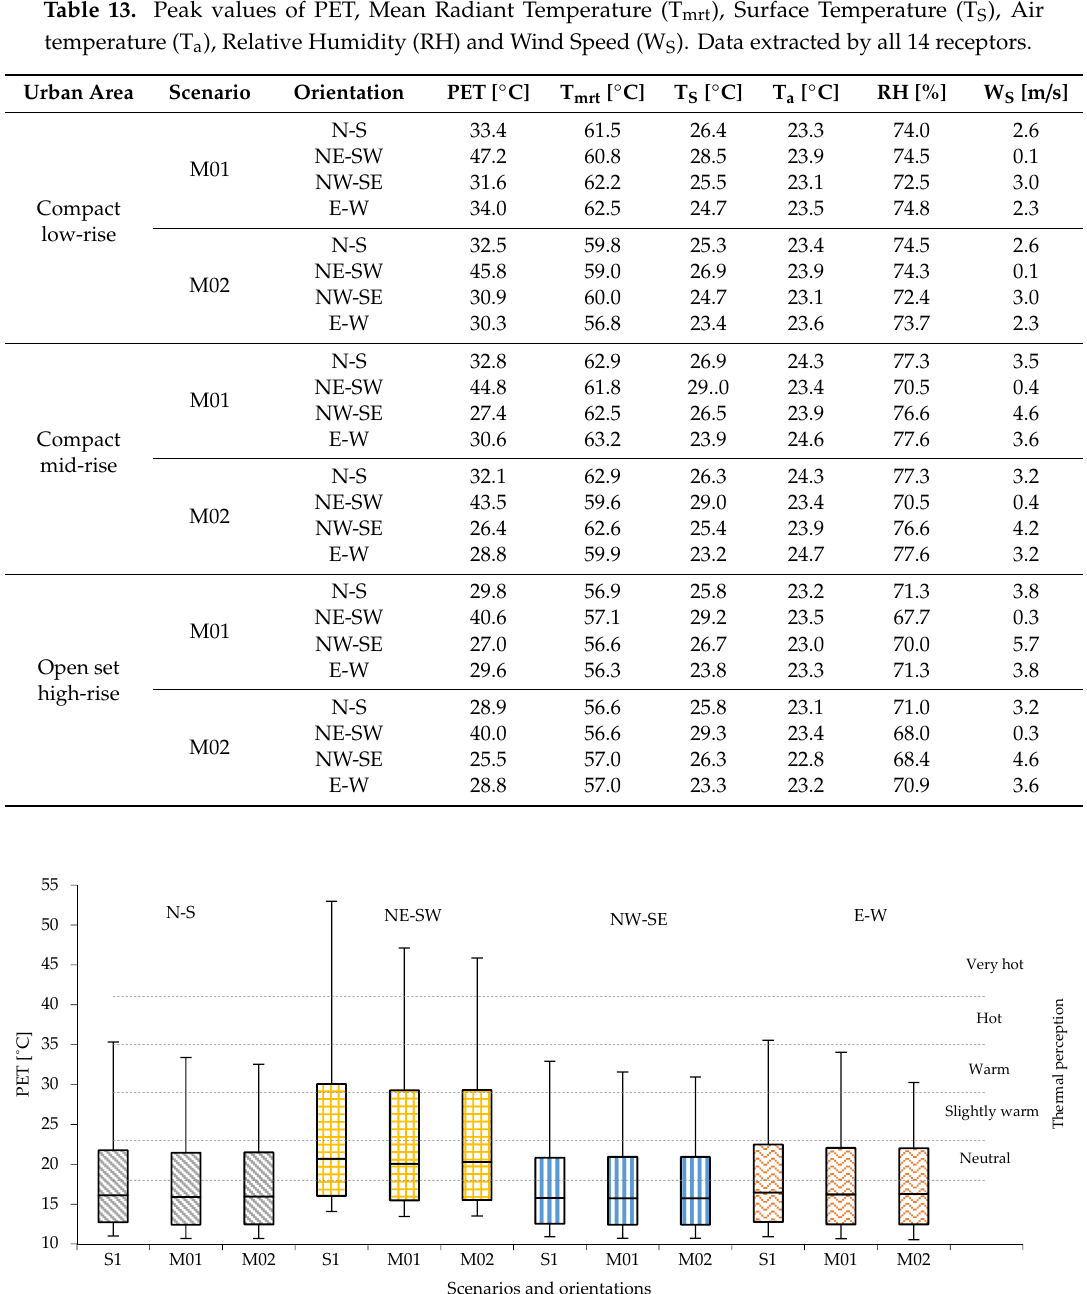
Table 14. PET peak values, for R01, R04 and R07 in compact lo-rise urban areas for the scenario with red brick stones, M01 (pavement in red brick stone and constant ratio Ht/H = 0.25) and M02 (pavement in brick red stone and constant ratio Ht/H = 0.25 and Wt/W = 0.30). Urban Areas